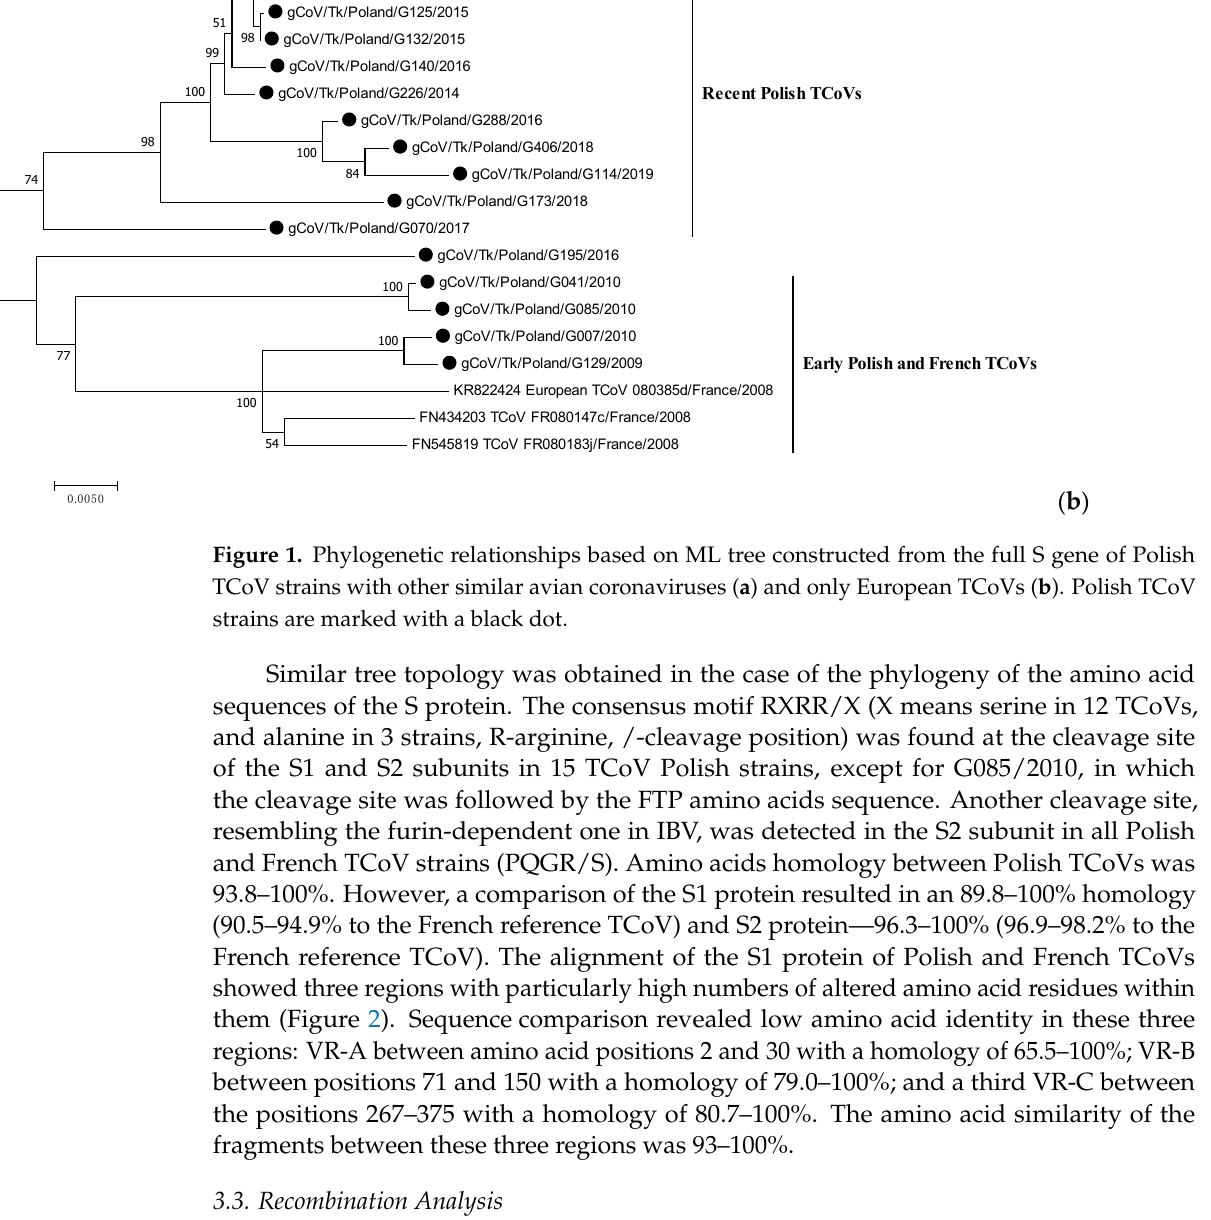
Shaded fields indicate nucleotide identity between Polish and those available in the GenBank French TCoV strains from a given phylogenetic Group 1 and 2. (dark grey—between strains of Group 1, light grey—between strains of Group 2) The analysis showed that the strains from the same year and region were the most similar (G132/2015 and G125/2015 from the Warminsko-Mazurskie voivodeship), while